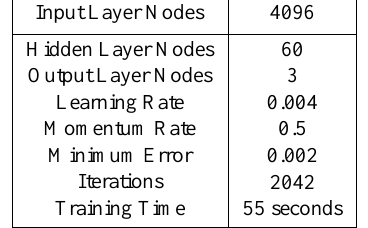
Table 3. Trained neural network final parameters VIANN